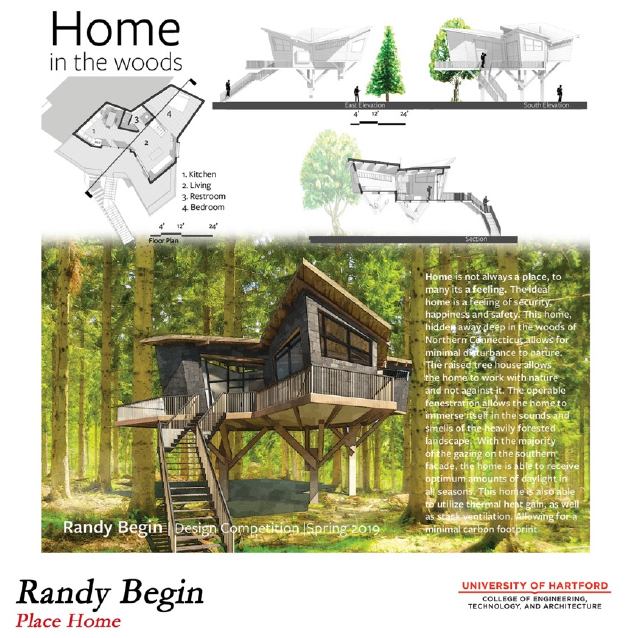
Figure 10. Land as part of the essence of design as shown in the 2019 HOME competition at Building Beauty.